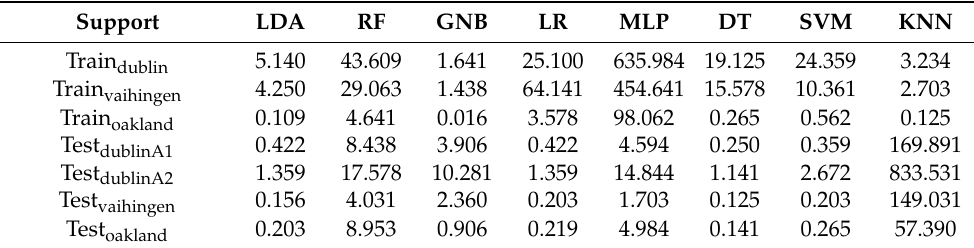
Table 9. Training and testing duration of the algorithms